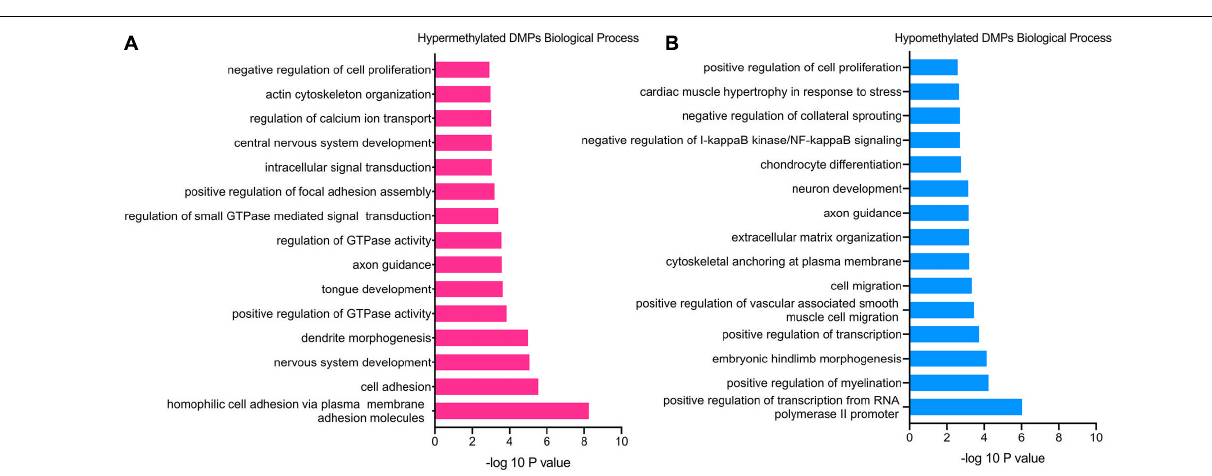
log2| fold change| > 1 and p < 0.05) were analyzed. The majority of the genes’ expressions were negatively related to methylation levels. It meant that the downregulated genes’ expression